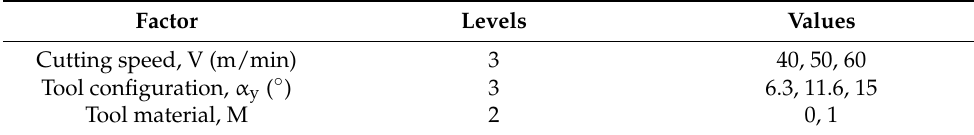
Table 5. Values of the factors used in the ANOVA analysis. Factor Levels